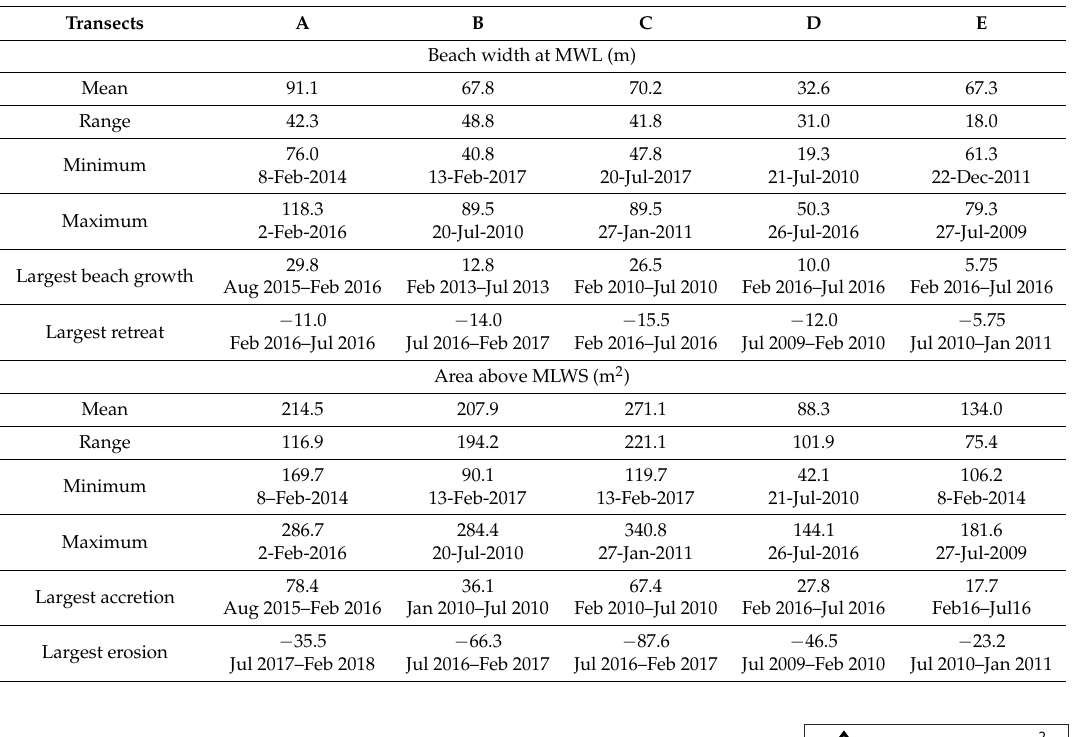
Table 2. Descriptive statistics summarising changes in beach width and area (and respective dates where relevant) based on dataset 1 for Transects A to E.